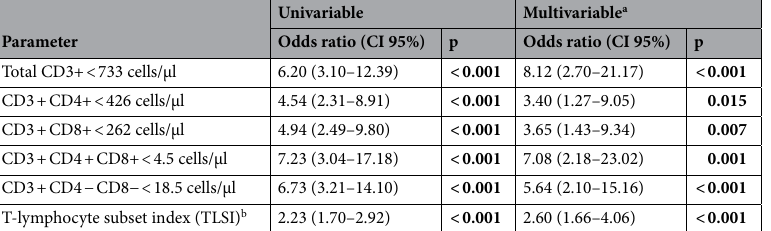
Table 7. Univariable and multivariable logistic regression analysis for severity-related risks in patients with SARS-CoV-2 infection. Statistically significant p values are highlited in bold. N/L ratio neutrophil-to- lymphocyte ratio, CRP C-reactive protein, LDH lactate dehydrogenase, AST aspartate transaminase, INR international normalized ratio, IL-6 interleukin-6. Univariable and multivariable logistic regression were performed. Odds ratios and 95% Confidence Interval (CI 95%) are reported. A two-sided p value of < 0.05 was considered statistically significant. a Adjusting for age, gender, number of comorbidities, hemoglobin, white blood cell absolute counts, N/L ratio, CRP, LDH, AST, Creatinine, INR, d-dimer and IL-6. b The number of T-lymphocyte subset absolute counts under the cut-off value, ranging from 0 to